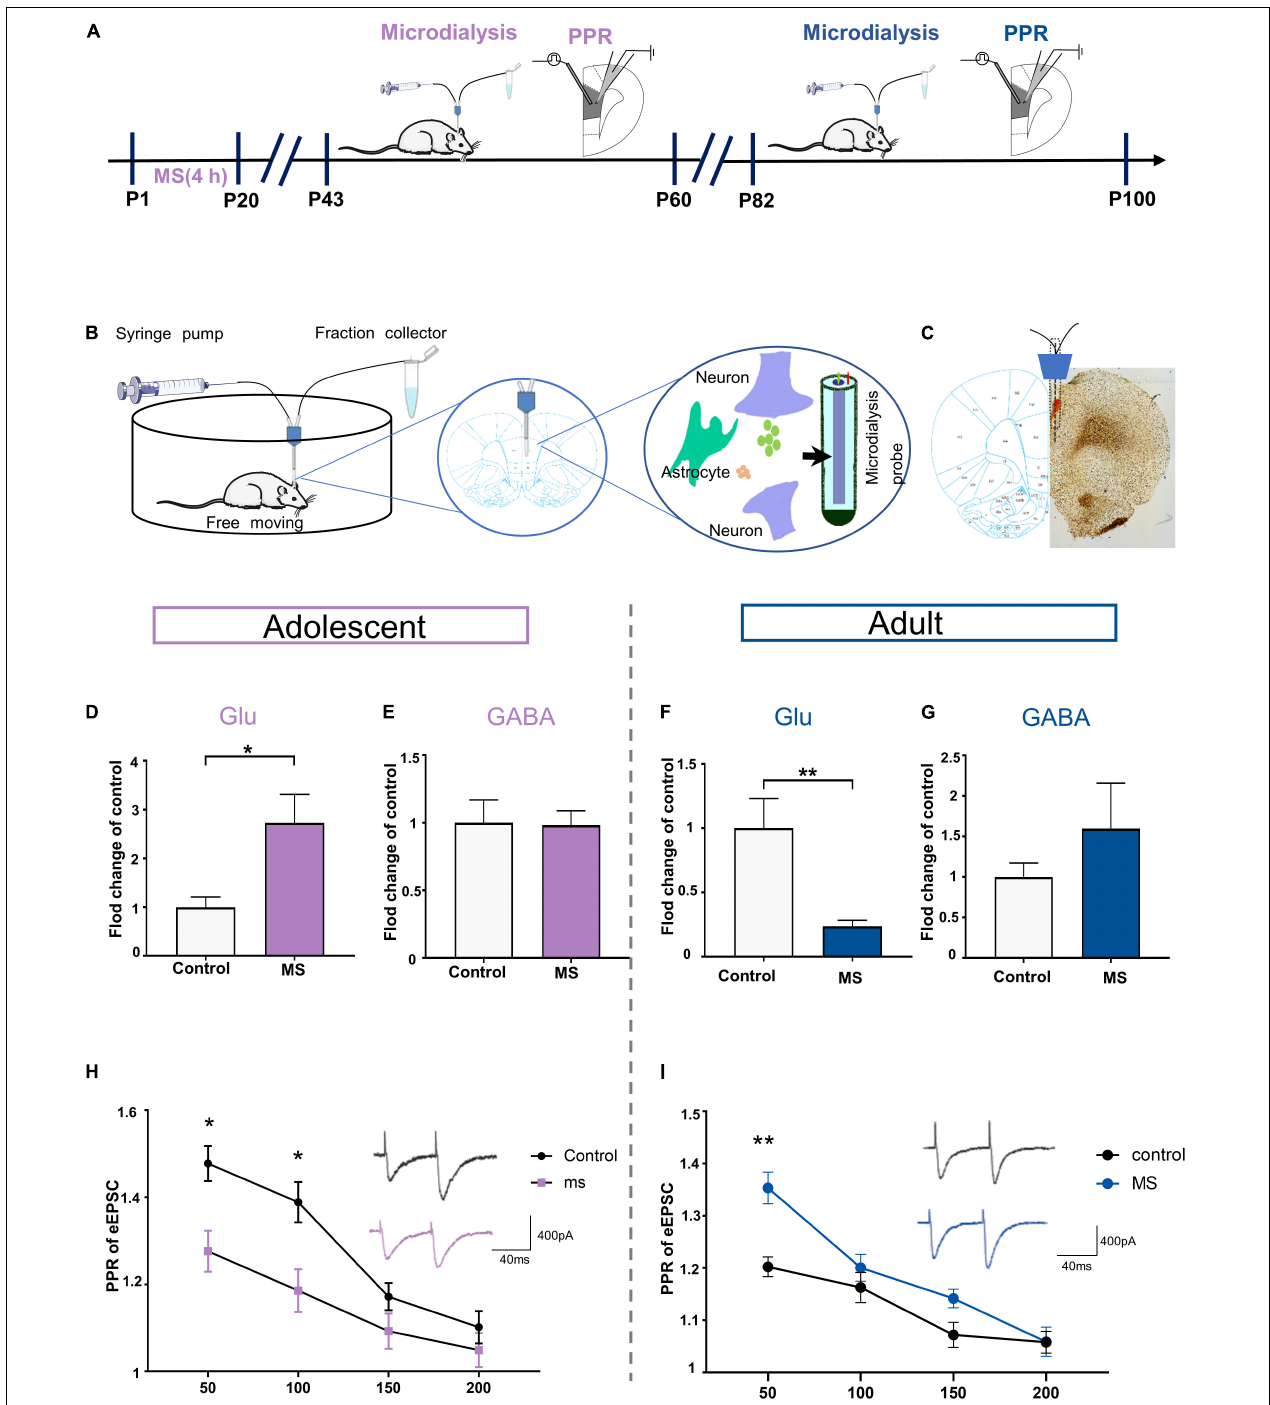
FIGURE 6 | Maternal separation induces the expression of different glutamate levels in rat PrL in adolescence and adulthood. (A) The experimental timeline of MS, microdialysis and whole-cell recording (PPR analysis). (B) Schematic diagram of microdialysis experiment flow. (C) A coronal view showing the microdialysis probe at prelimbic cortex. (D,E) Represents the changes of glutamate and GABA level in mPFC recorded by microdialysis in vivo in adolescent rats ( n = 6–7). (F,G) Represents the changes of glutamate and GABA level in mPFC recorded by microdialysis in vivo in adult rats ( n = 5–6). (H) PPR evoked by paired stimuli (interstimulus interval: 50, 100, 150, and 200 ms) in mPFC L2/3-L5 synapses for control and MS in adolescent ( n = 15 cells, 3–4 rats each group). Right: Representative traces PPR with interstimulus interval of 50 ms for control and MS in adolescent. Scale bars: 400 pA, 40 ms. (I) PPR evoked by paired stimuli (interstimulus interval: 50, 100, 150, and 200 ms) in mPFC L2/3- L5 synapses for control and MS in adult (control: n = 3–4 rats, cell = 15; MS: n = 3–4 rats, cell = 20). Right: Representative traces PPR with interstimulus interval of 50 ms for control and MS in adolescent. Scale bars: 400 pA, 40 ms. * p < 0.05, ** p < 0.01. Data are the means + SEM.